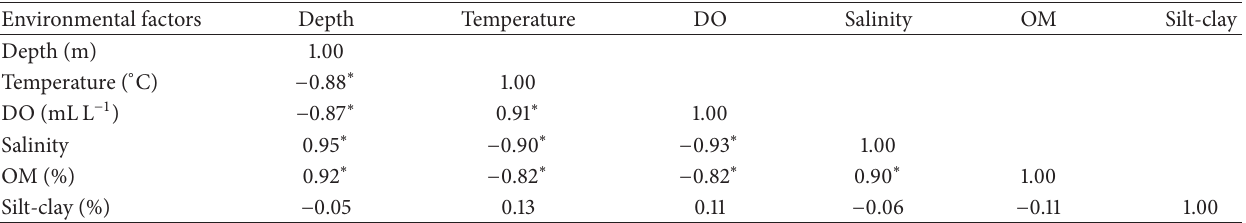
Table 2: Correlation coefficient of environmental factors, dissolved oxygen (DO), and organic matter (OM); 𝑁 = 34 , ∗ 𝑃 > 0.05 . Environmental factors Depth Temperature DO